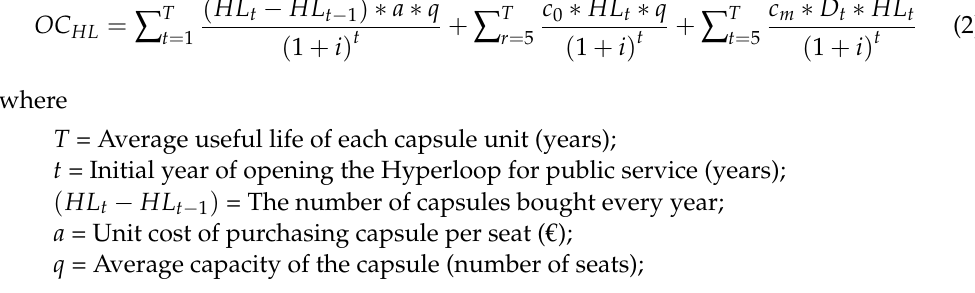
Figure 3. High-capacity capsule.